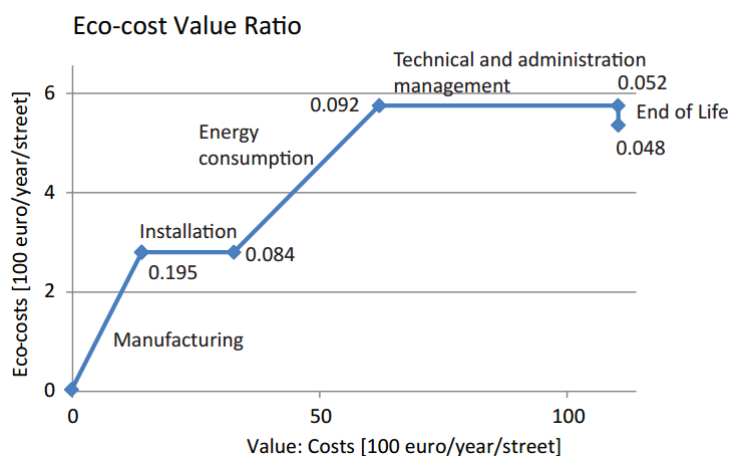
Figure 11. The 2-dimensional representation of costs and eco-costs of the base case (one street, one year). The absolute EVR is provided at each point of the curve.